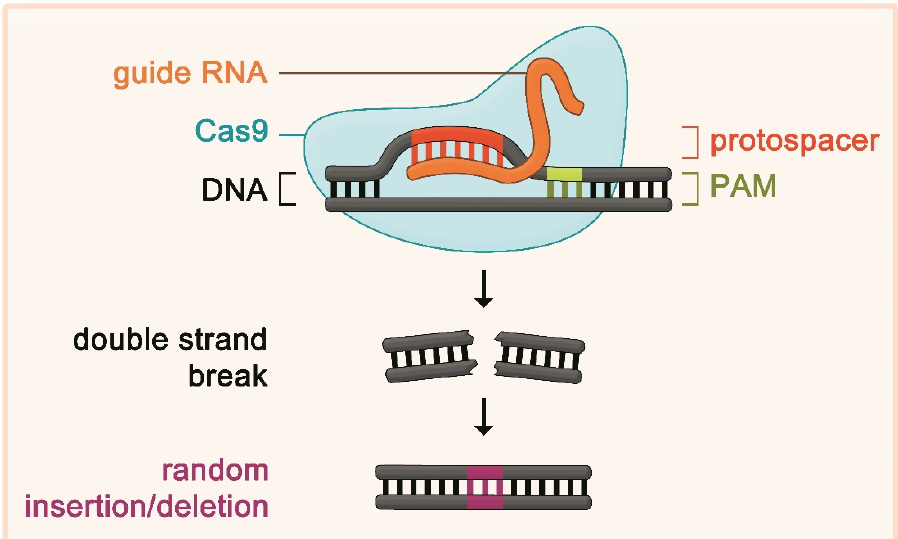
Figure 1. Shown is the principle of using the clustered regularly interspaced short palindromic repeat (CRISPR)/CRISPR-associated (Cas) system for genome editing. The programmable guide RNA (gRNA) complementary binds to a specific DNA sequence termed “protospacer”. The DNA–gRNA complex recruits a nuclease such as Cas9. The nuclease has to interact with a specific DNA sequence next to the protospacer termed “protospacer-adjacent motif” (PAM) in order to work. If these requirements are fulfilled, the nuclease introduces a double strand break in the DNA. Endogenous DNA repair mechanisms follow. These repair mechanisms are error-prone and lead to random insertions or deletions, which, in turn, render the gene and the encoded protein dysfunctional. In a further development, the catalytic domain of Cas9 has been deactivated and fused to a base editor, which does not introduce double strand breaks, but precise single-nucleotide changes.